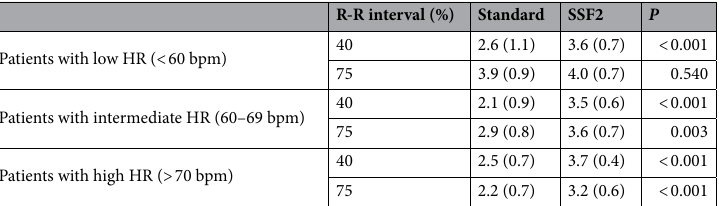
R-R interval (%) Standard SSF2 P